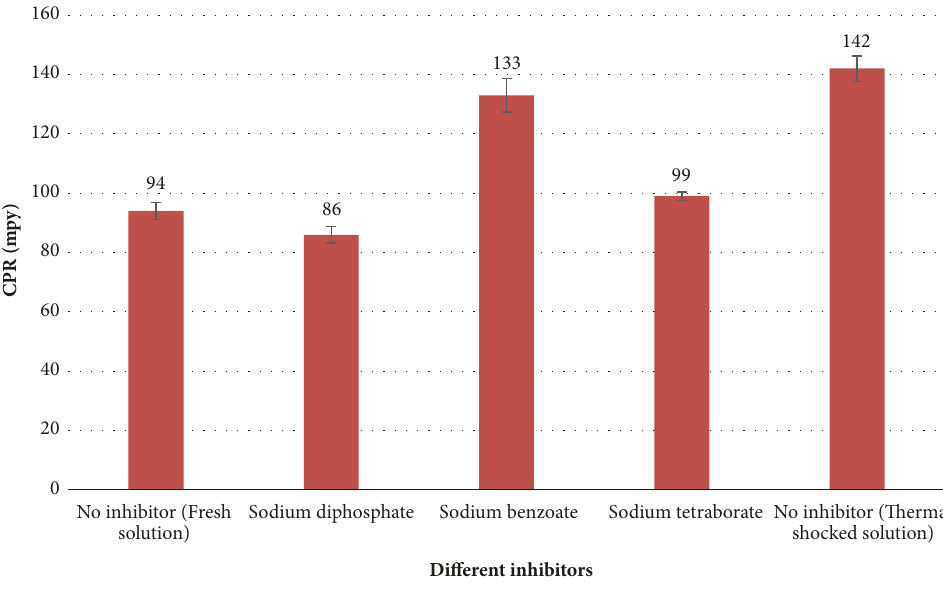
Figure 5: Corrosion rate of aluminum alloy 3303 in different